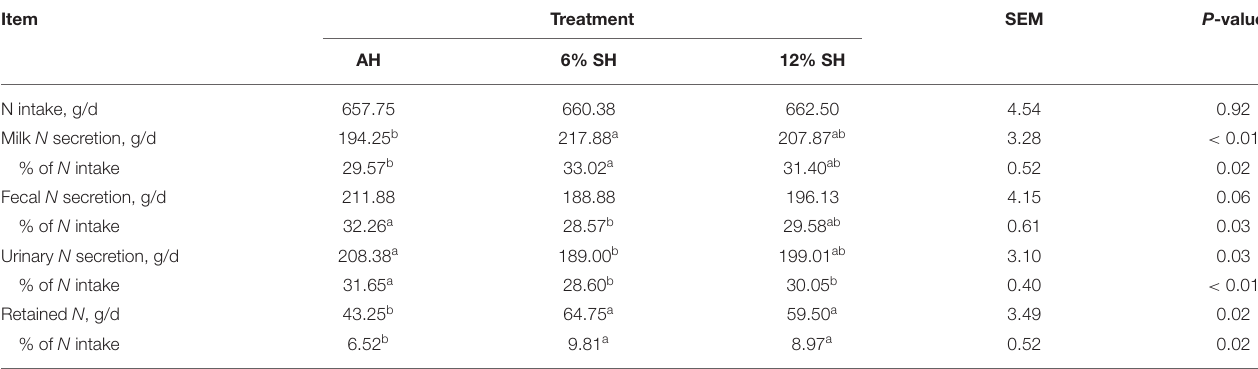
TABLE 5 | Effect of partial substitution of AH by SH on nitrogen utilization.